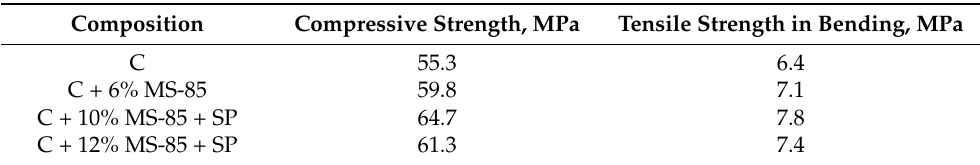
Table 11. Results of tests for strength in compression and tensile in bending of cement bar specimens with different MS